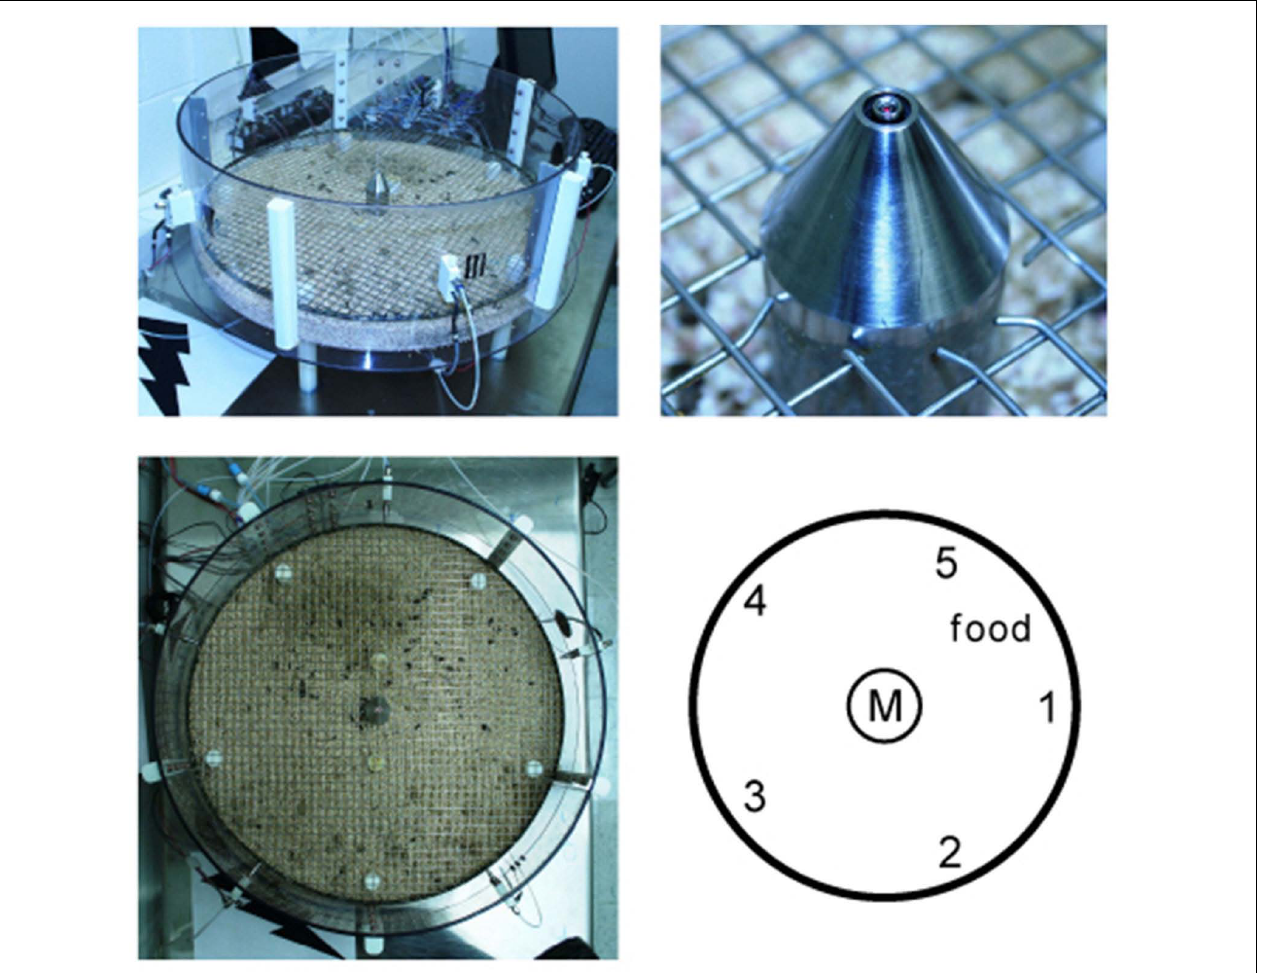
lickometer. Lower right shows a diagrammatic top view of the arena with central taste manifold (M) and the five surrounding water reward spout (1–5) of actual picture on the